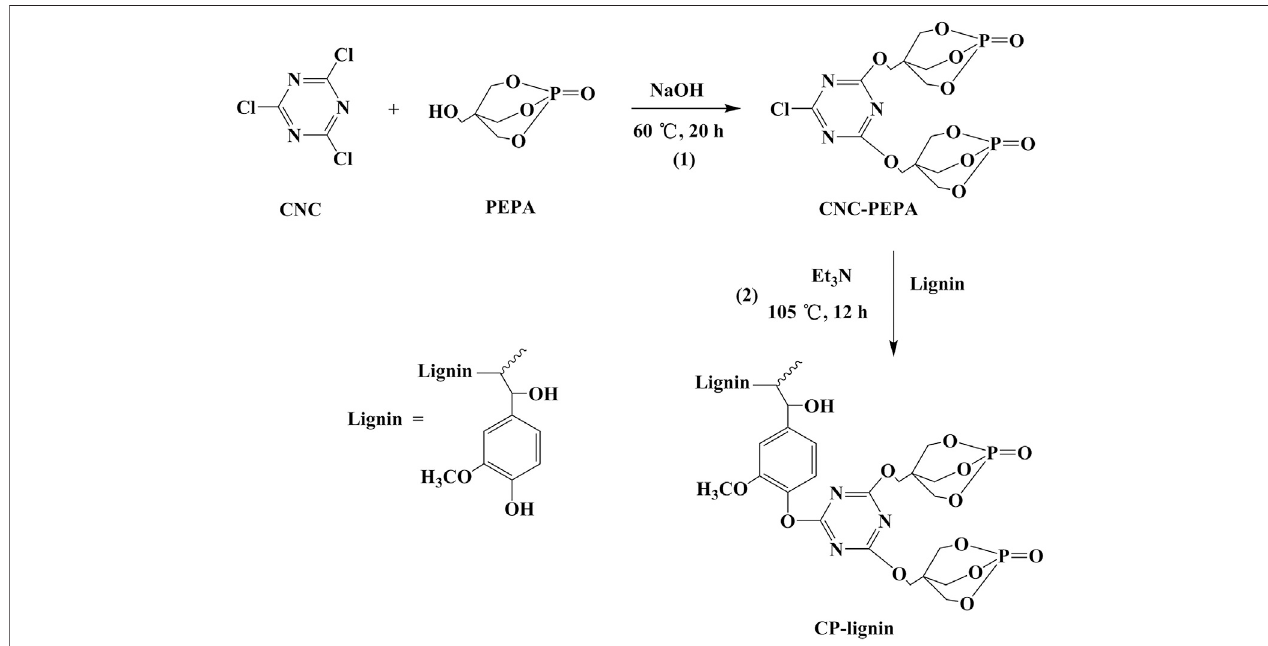
FIGURE 12 | Synthesis of CP-lignin (Chen et al.,